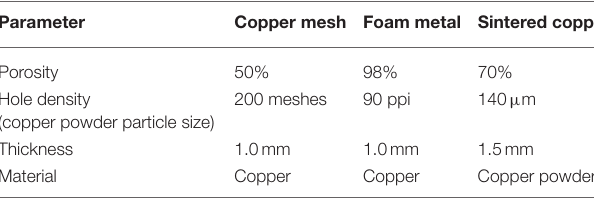
Material Copper Copper Copper powder